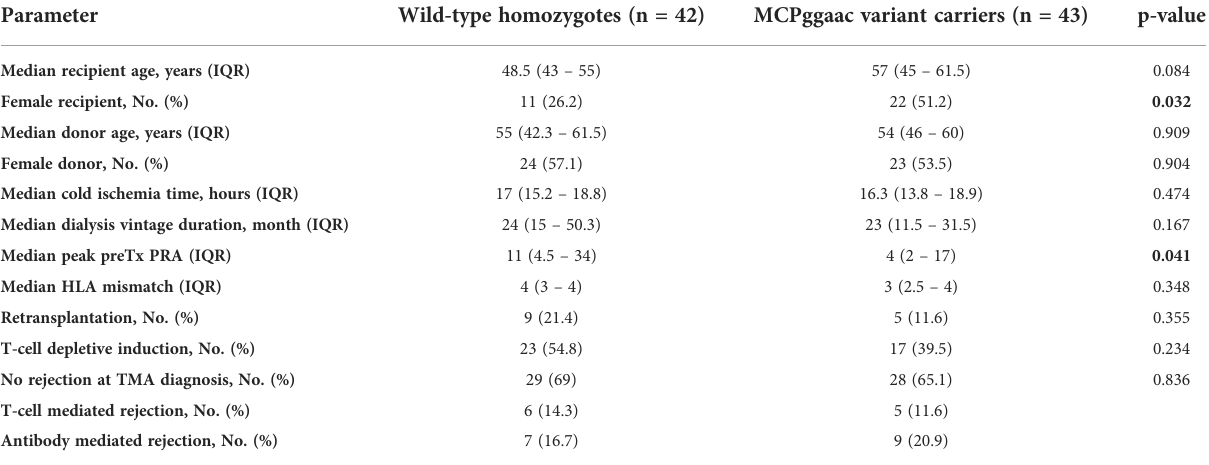
TABLE 3 Clinical parameters according to MCPggaac haplotype in the TMA group.